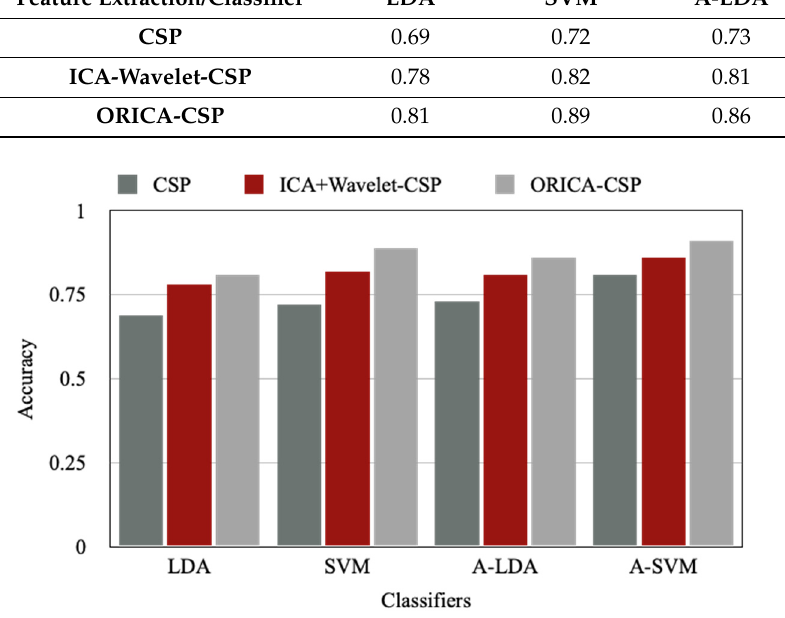
Figure 11. Classifier comparison chart with different feature extraction methods. Table 5. The average classification accuracy of several feature extraction techniques is compared.